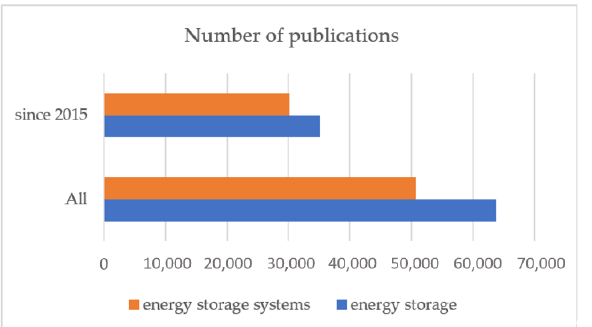
Figure 1. The number of publications in IEEE Xplore with “energy storage” and “energy storage systems” as the search term.